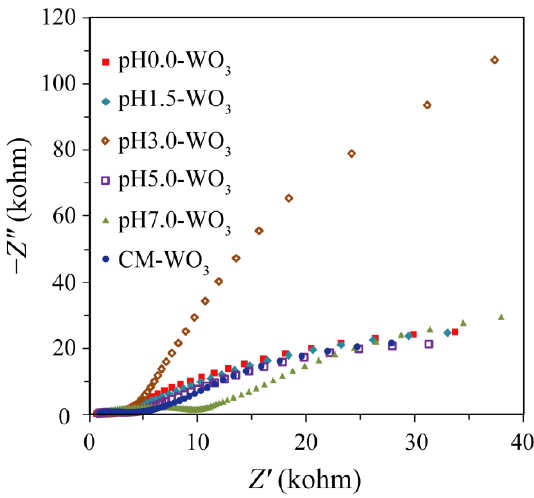
Figure 9. Electrochemical impedance spectra Nyquist plots of the as-prepared pH x -WO 3 and the CM-WO 3 samples.